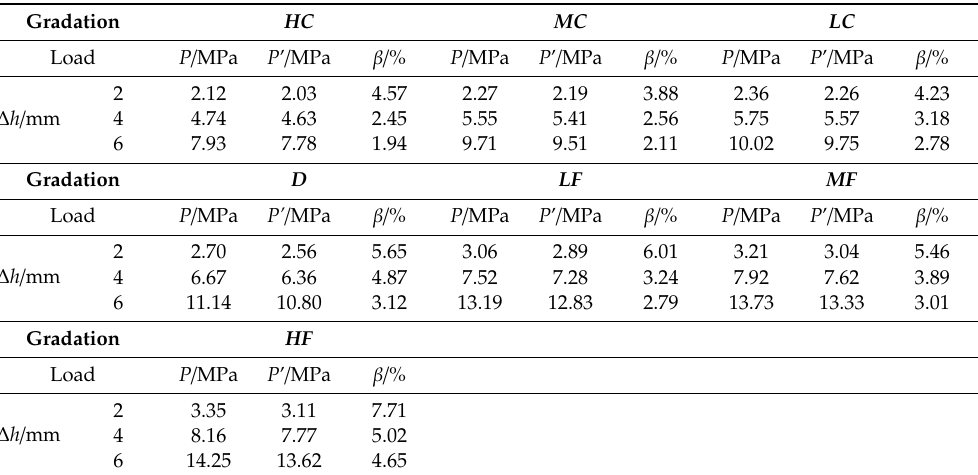
Table 5. Vertical loading in laboratory and DEM